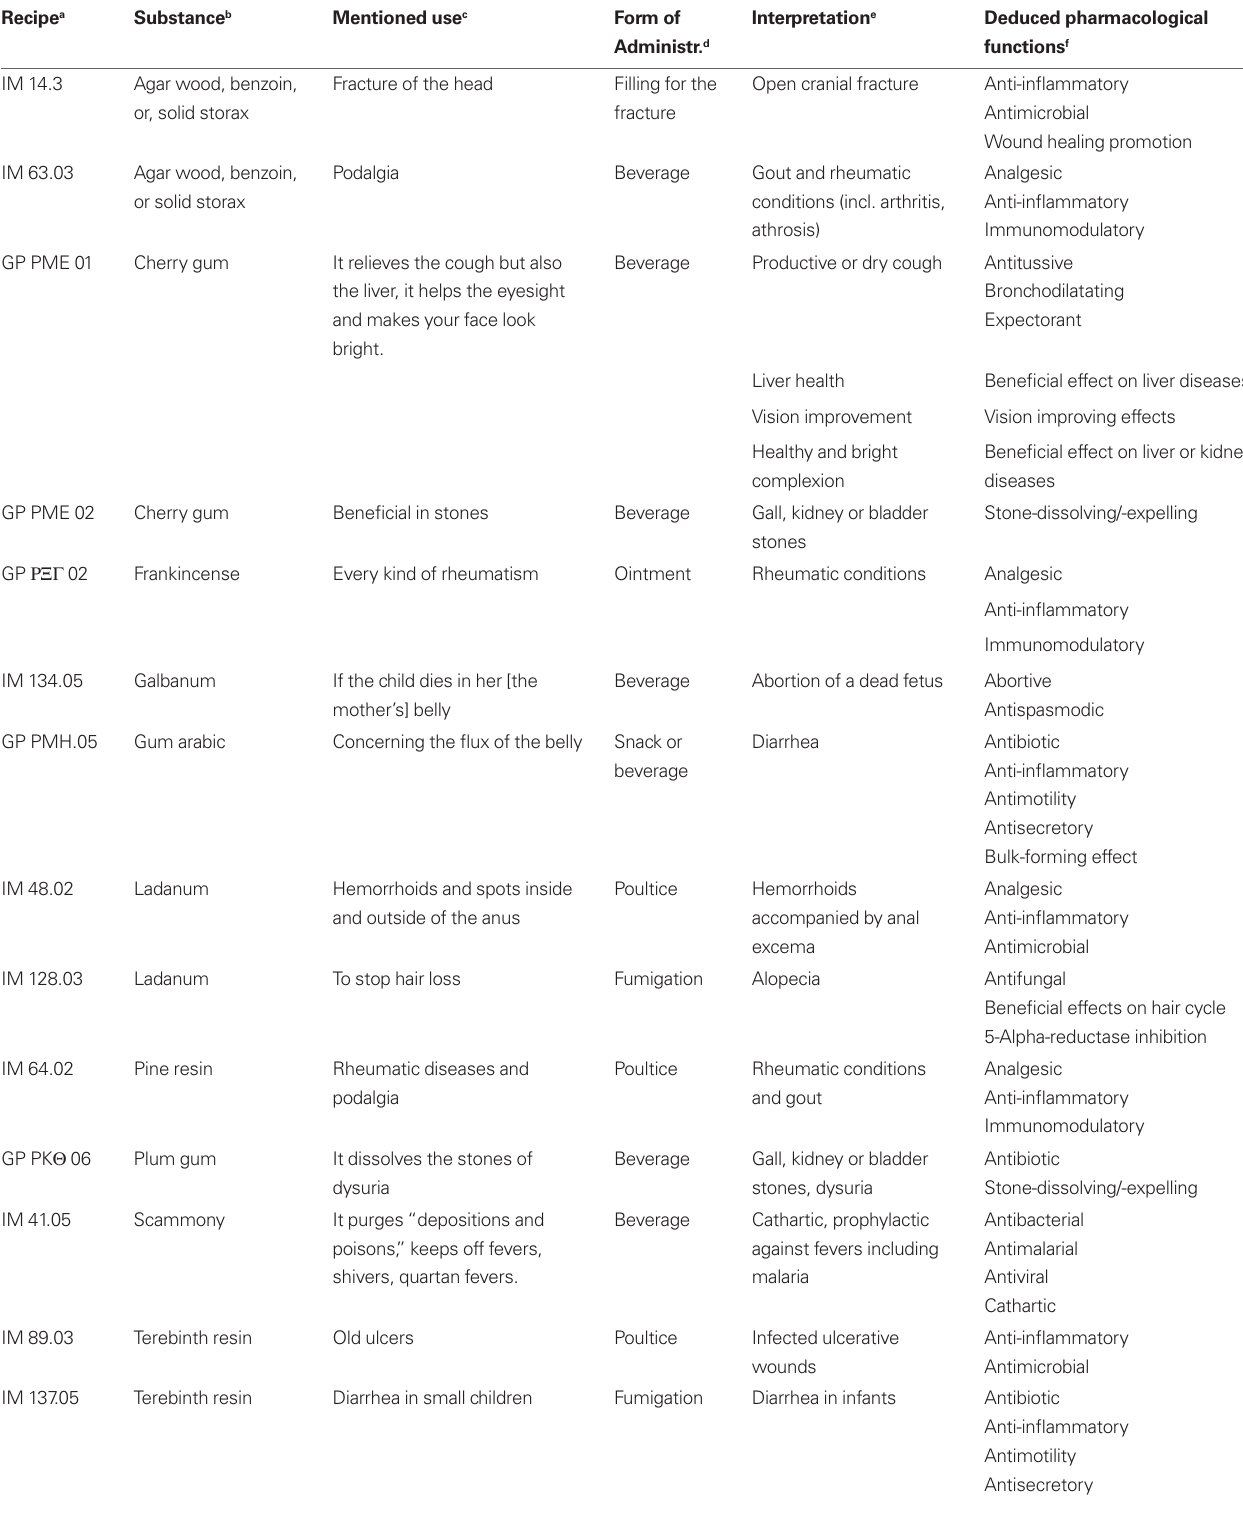
Table 5 | Simple remedies in the iatrosophia : interpretation of the mentioned use and deduced pharmacological functions. Recipe